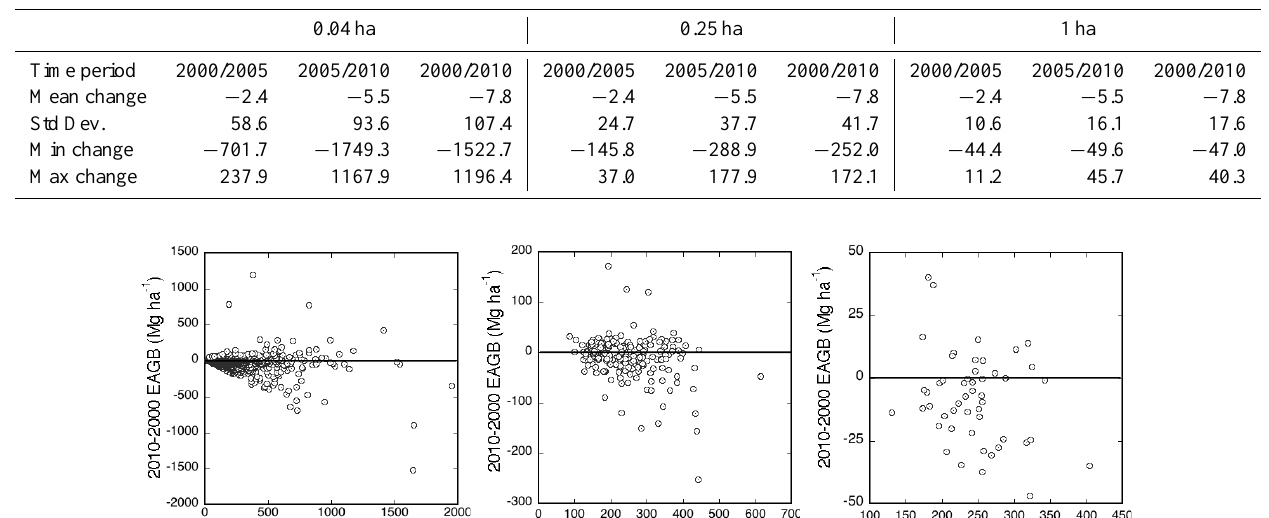
Table 4. AGB change (in Mgha − 1 ) between 2000, 2005 and 2010, from field estimations, at three spatial scales. AGB decreased both between 2000 and 2005 and between 2005 and 2010 census periods in the 50ha plot. AGB changes are more stable at 1ha than at 0.04ha.